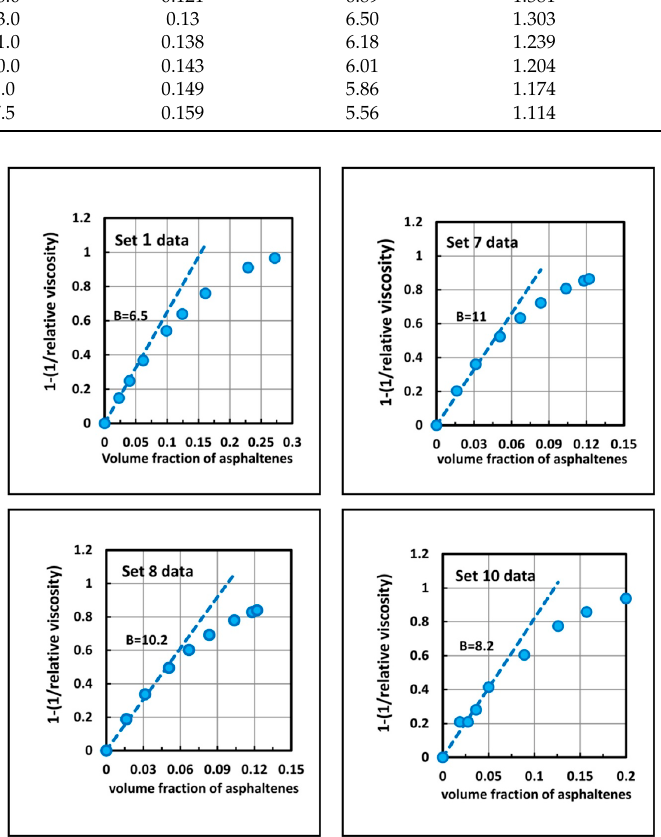
Figure 10. Estimation of virial coefficient B of asphaltene suspensions.